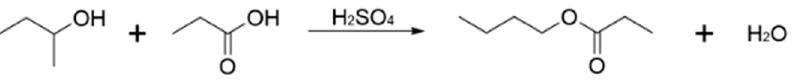
( b ) Figure 7. ( a ) TGA and ( b ) DTG data curves of n -octadecane and the microPCMs. 3. Temperature Control Experiments 3.1. Reaction Scheme Esterification reaction is a strongly exothermic reaction that is widely used in indus- trial production. In this study, the esterification reaction between propionic anhydride (PA) and 2-butanol (2B) were chosen as the research subject, and the equation is shown in Scheme 1.